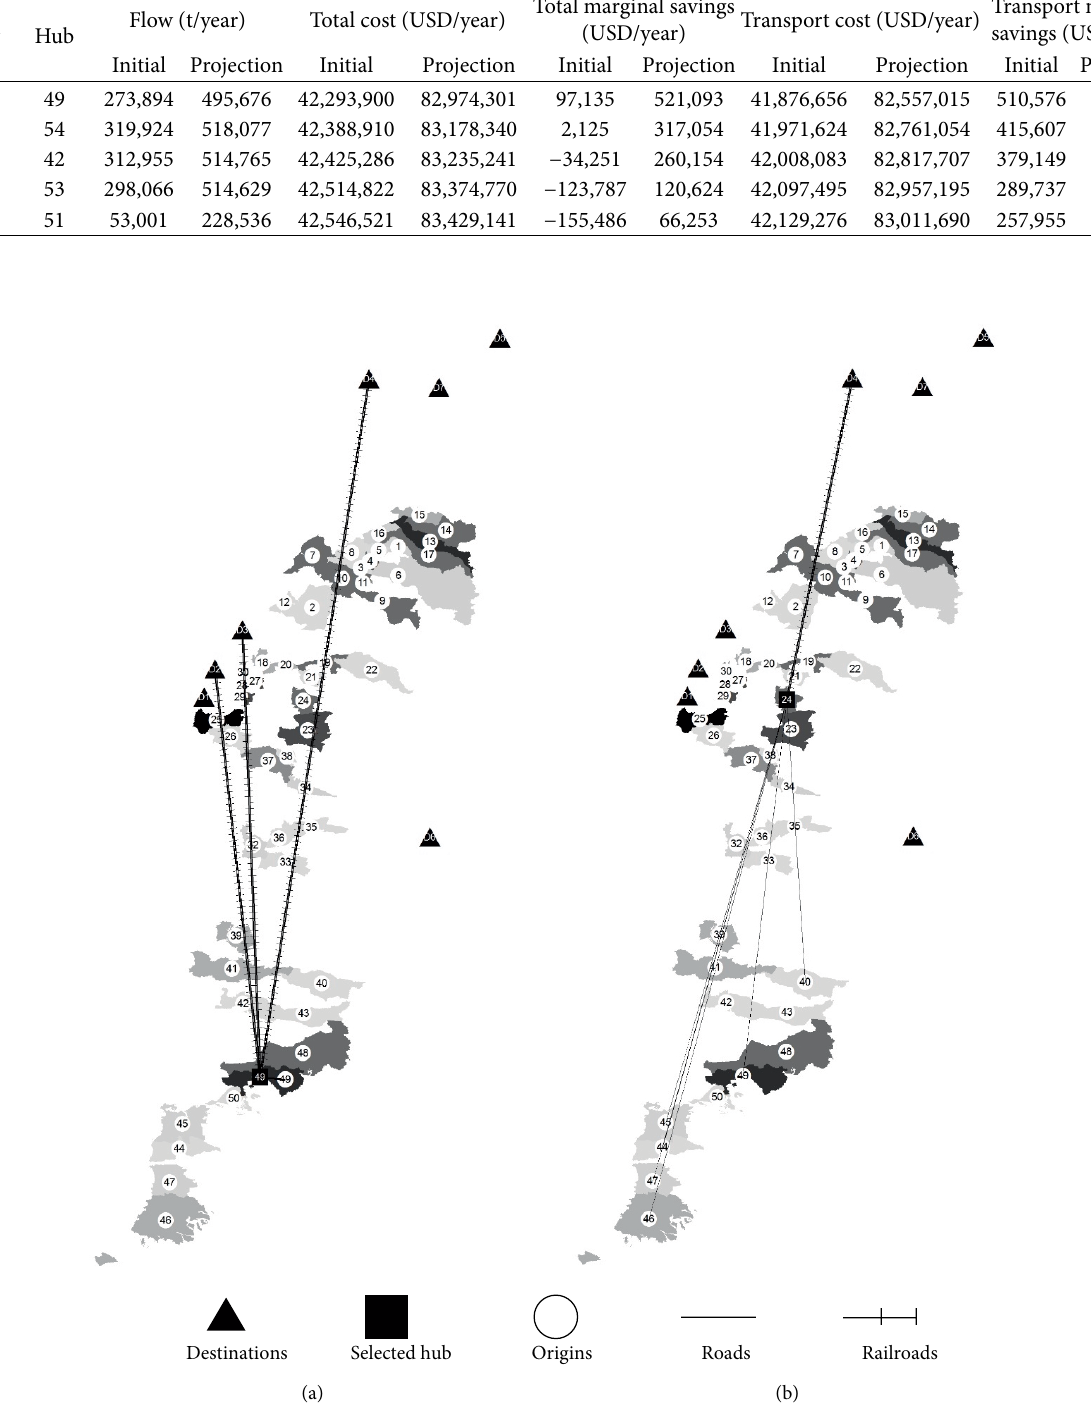
Figure 2: Different hubs, allocation comparison. (a) The best hub. (b) Hub 24, a hub close to